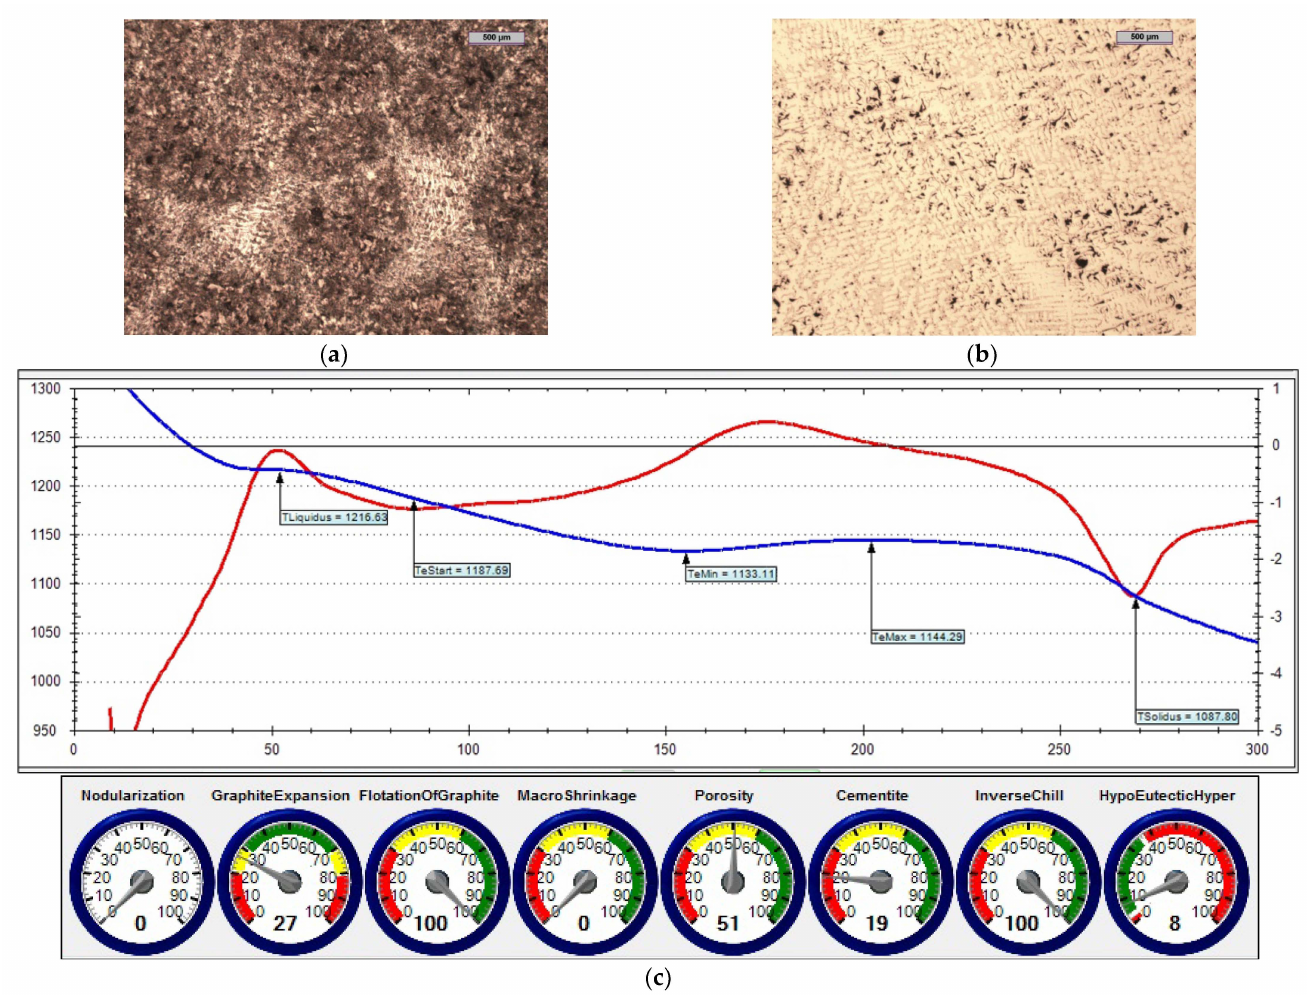
Figure 18. Reference grey cast iron (with 0.09% S content): ( a ) sample etched with Picral reagent; ( b ) non-etched sample; ( c ) changes in cast iron temperature during crystallisation and cooling of casting according to ITACA system.